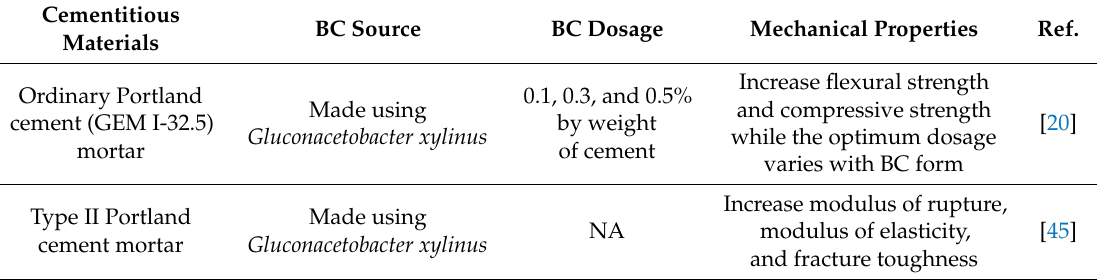
Table 3. Mechanical properties of cementitious materials with